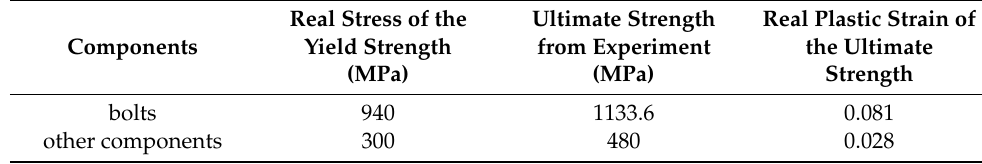
Table 5. Material properties of the